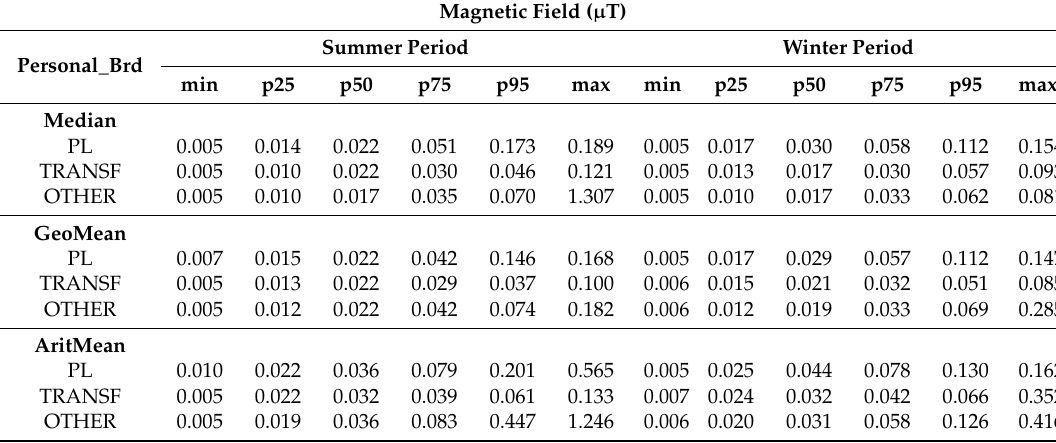
Table A1. Distribution values of the median, geometric mean (geomean) and arithmetic mean (aritmean) of magnetic field ( µ T) in the broadband (Brd) frequency range (40–800 Hz) for personal measurements for each group (PL, TRANSF, OTHER) in both summer and winter